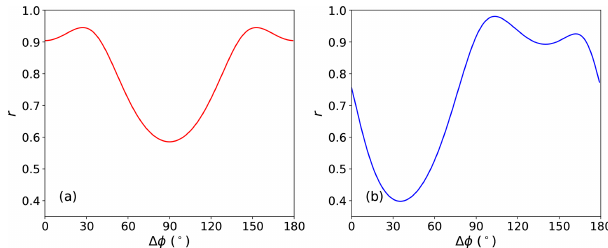
Figure 5. Correlation coefficients for the linear-regression relation- ship of N rp : N b , where n is rotated counterclockwise by (cid:49)φ de- grees relative to (a) n p1 and (b) n f . The perturbation points ana- lyzed here are the same as in Fig.